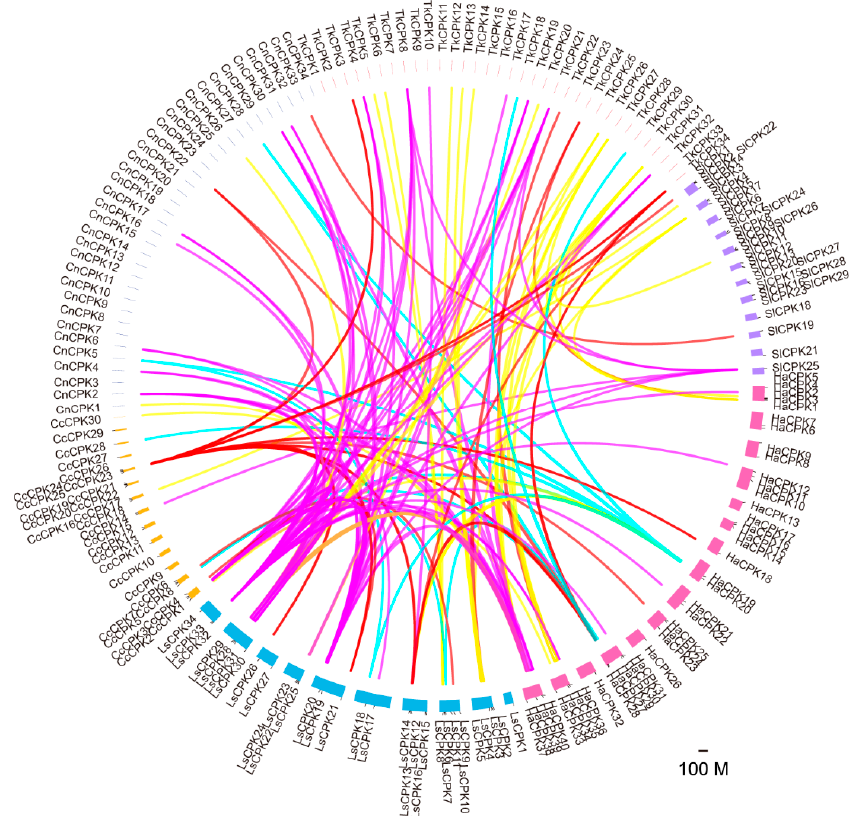
Plants 2019 , 8 , x FOR PEER REVIEW Figure 3. Duplication and syntenic analysis of CPKs in Asteraceae plants and S. lycopersicum . Chromosomes and scaffolds are shown in different colors and all CPK gene locations are indicated. The syntenic relationship of CPKs in four different groups are connected by different colored lines: group I (yellow), Group II (red), group III (magenta) and Group IV (blue).